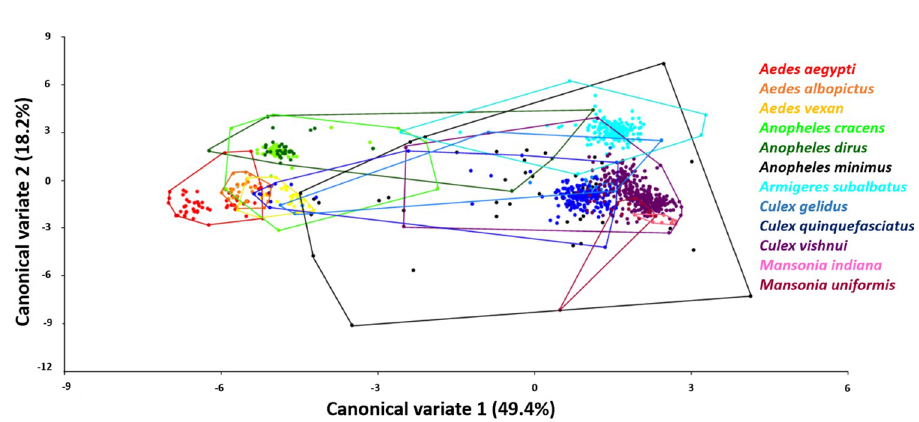
Fig 4. Scatter plot showing wing shape variation among 12 mosquito species. Wing shape variation is shown along the first CV1 and CV2 axes with 90% confidence ellipses.